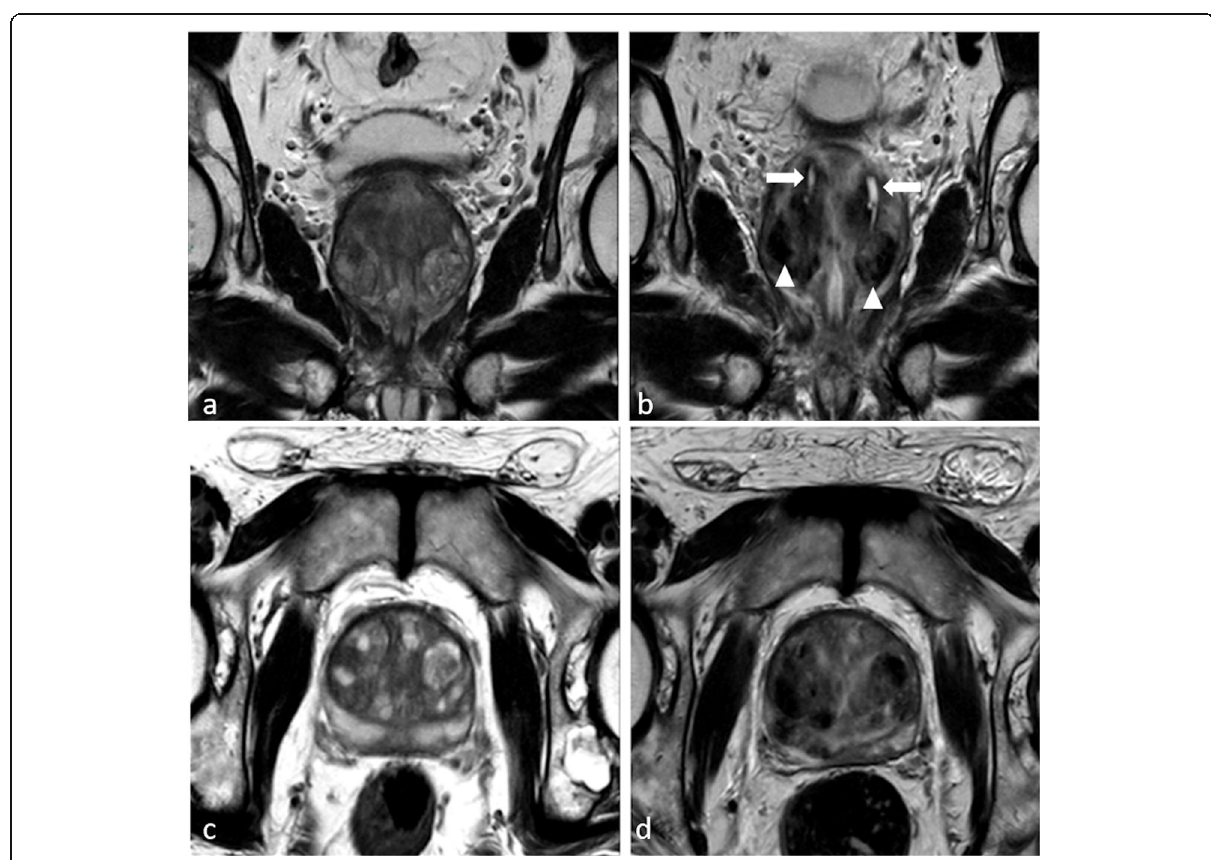
Fig. 2 Large bilateral symmetrical bilobar adenoma in a 62-year-old patient before treatment, on magnetic resonance imaging T2-weighted sequences along the coronal ( a ) and axial ( c ) planes. The same sequences, along the coronal ( b ) and axial ( d ) planes, performed immediately after transperineal prostate laser ablation show only longitudinal linear hyperintensities ( arrows ) surrounded by hypointense elliptical-shaped charred tissue ( arrowheads ) at the site of laser fibre tracks. At this time, no signs of coagulative necrosis are yet